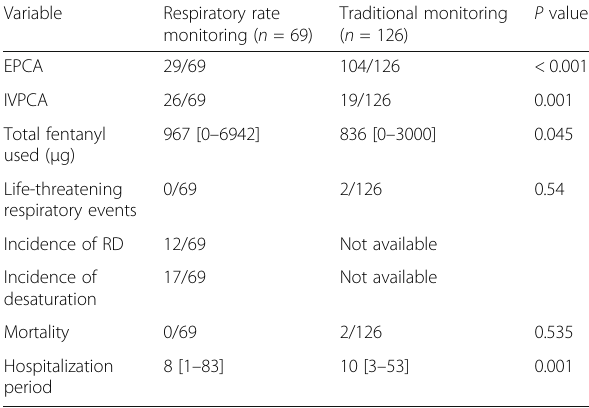
Table 2 Baseline characteristics of study patients Variable